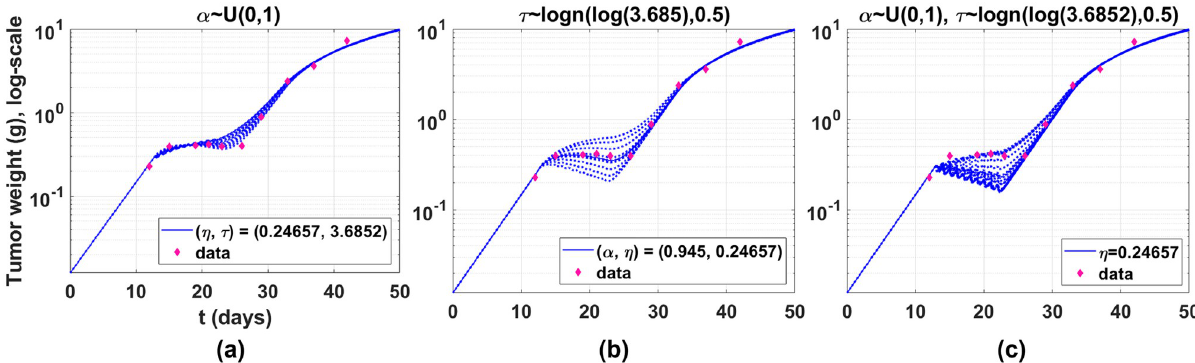
Fig 4. Delays of fractional TCM upon variations of α and τ . (a) Ten points of α ’s are selected from the uniform distribution. Delay is larger when α is smaller. (b) Ten points of τ ’s are selected from the lognormal distribution with mean log(3.685) and variance 0.5. Delay is larger when τ is larger. (c) Twenty points are randomly selected from the uniform and lognormal distributions. The model accurately captures various delays caused by drug injections. Additionally, the model shows that tumors begin to increase after stopping doses. https://doi.org/10.1371/journal.pone.0276654.g004 in fractional TCM, and k and η with n = 4 are estimated in Erlang TCM according to the 1 number of data. Initial and parameter ranges are given by ( k , η ) = (0.4, 0.1) from [0, 0] to [10, 1 1] for Erlang TCM and ( α , η , τ ) = (0.93437, 0.1, 1) from [0.01, 0, 1] to [0.95, 10, 10] for frac- tional TCM. Other parameters are the same as mentioned in previous sections. Model predic- tions for the two points of data are observed in Fig 5(a), and both models fail to predict full